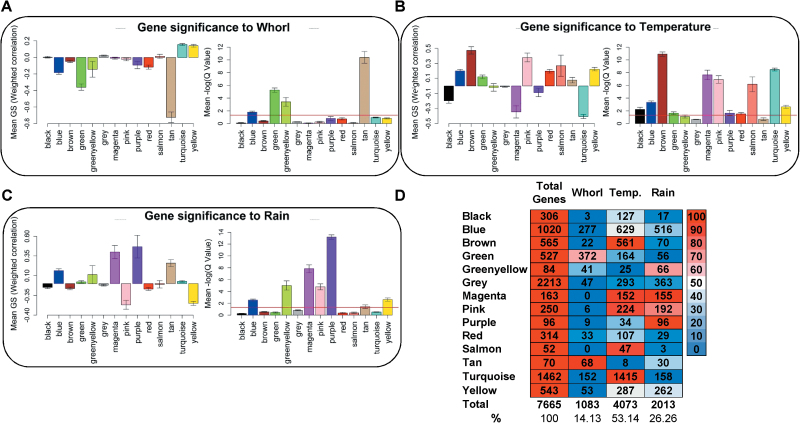
Summary of individual gene-weighted correlations with Whorl, Temperature, and Rain. (A) Means of the weighted correlations between genes and Whorl. (B) Means of the weighted correlations between genes and Temperature. (C) Means of the weighted correlations between genes and Rain. Error bars show standard errors of the samples. Means of the –log10 (q-values) of the weighted correlations for each module are shown. The horizontal red line indicates the threshold-significant q-value (1.3, the log10 equivalent of 0.05). The bar colours indicate the eigengene modules’ names. (D) Summary of significant weighted correlations (q-value < 0.05) between the individual genes and variables. Colours indicate percentages of genes in each eigengene module that have significant correlations with a trait. Intense blue and red indicate low and high numbers of significant correlations, respectively.